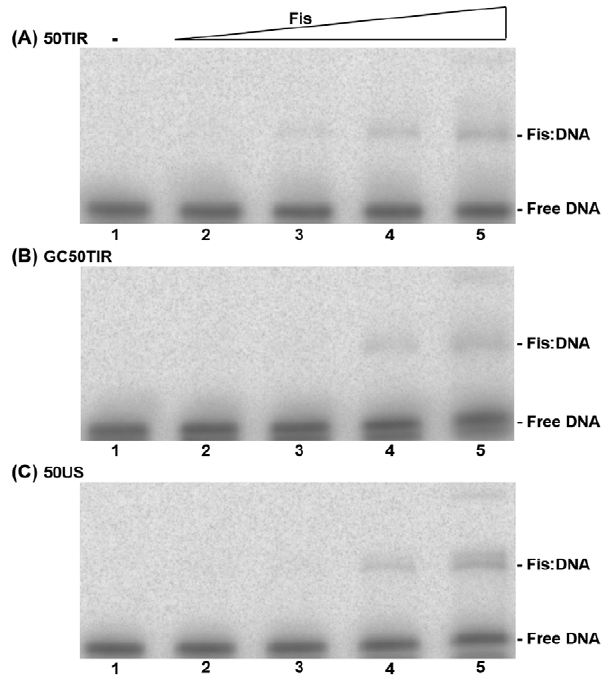
Figure 5. Fis interacts non-specifically with the vapB-1 TIR. Gel shift products from a titration of Fis, lacking a polyhistidine tag, with (A) 50TIR, (B) GC50TIR or (C) 50US are shown. The gels show the products of the following samples: DNA only ( lane 1 ) and the addition of Fis at 10, 30, 90 or 300 molar ratios with the DNA substrate ( lanes 2–5 ). The identity of each band is noted at the right of each gel. Each gel represents one of two independent experiments.